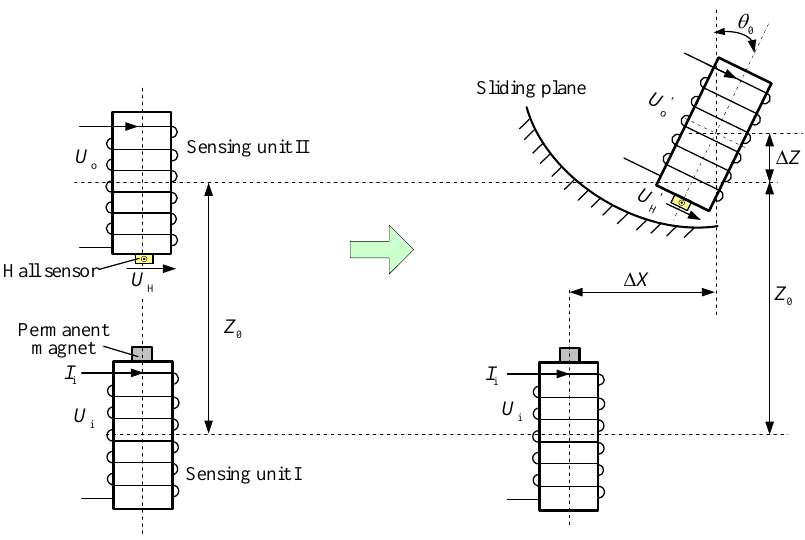
Figure 2. Principle diagram of the proposed underground displacement 3D sensor (only two adjacent sensing units are given). ( a ) Initial geometrical arrangement; ( b ) appearances of relative horizontal displacement Δ X , vertical displacement Δ Z and tilt angle θ 0 .